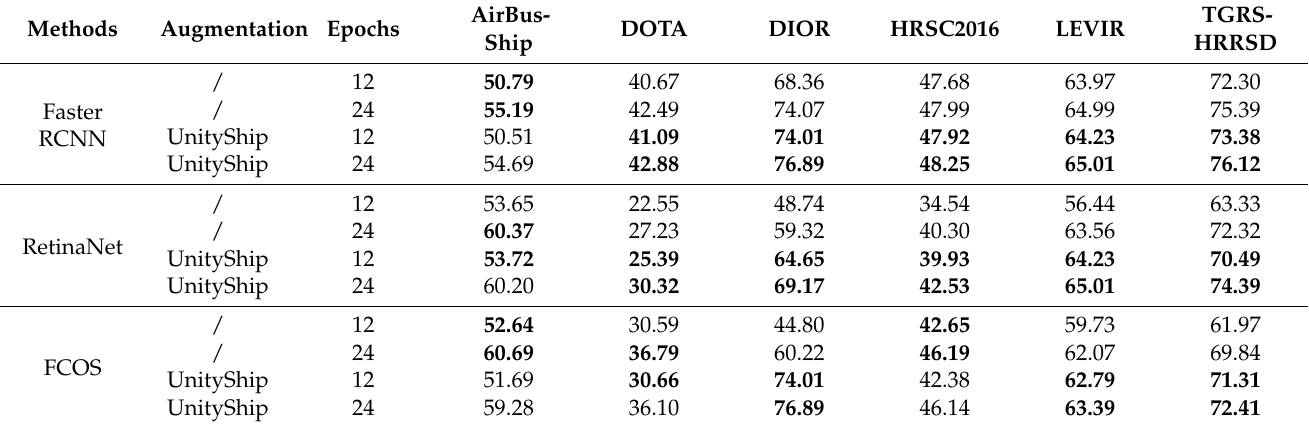
Table 6. Comparison of AP for different datasets with and without augmentation and different training schedules. The red indicates results for longer training schedules (24 epochs) and the green indicates results for shorter training schedules (12